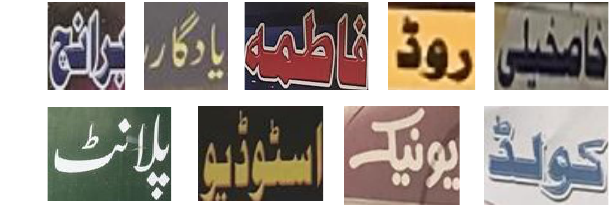
FIG. 5. SAMPLES OF SOURCE IMAGES